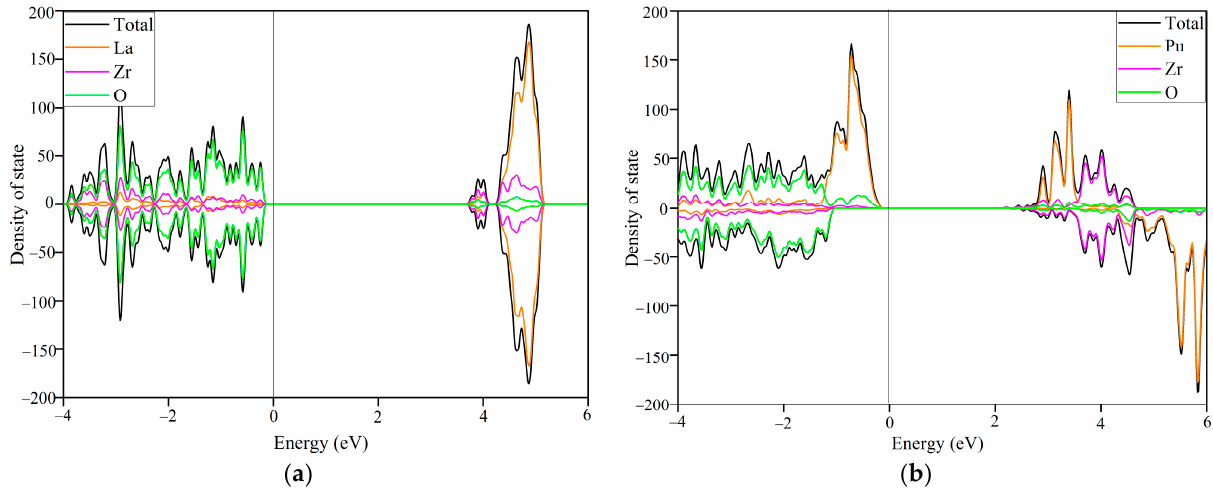
Figure 6. A comparison of the atomic projected density of state (DOS) distribution for ideal ( a ) La 2 Zr 2 O 7 and ( b ) Pu 2 Zr 2 O 7 .